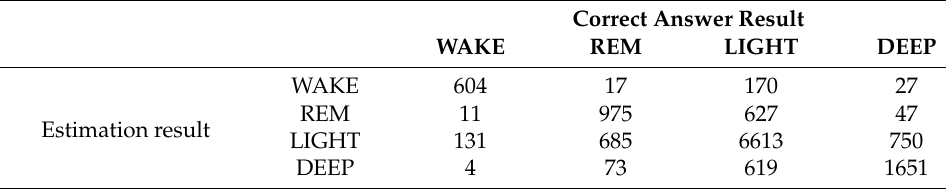
Table 5. Confusion matrix obtained from leave-one-out cross-validation ( n =